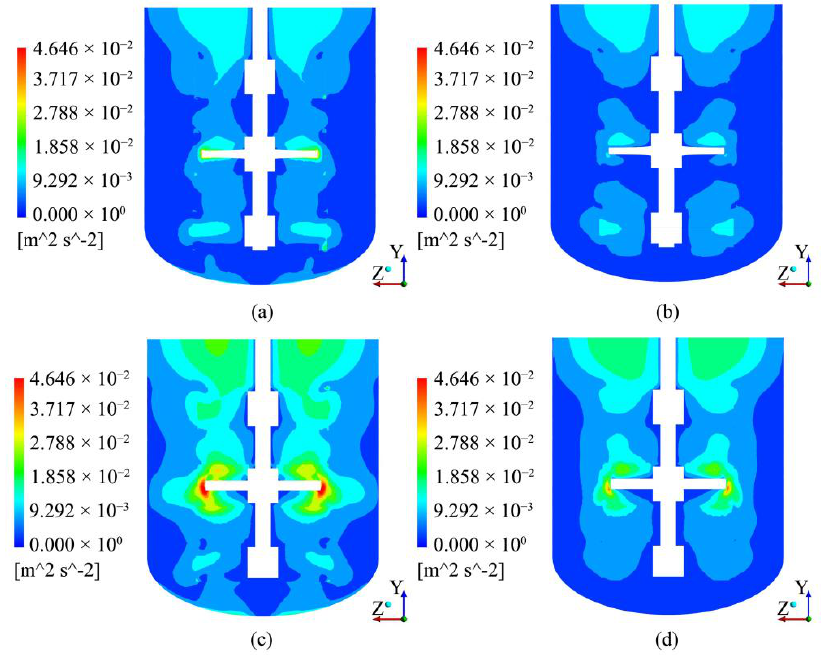
Figure 18. Cloud diagram of the turbulent kinetic energy in the YZ section. ( a ) Re = 2316.5, μ = 0.023 Pa·s,TBC-A type agitator; ( b ) Re = 44,910, μ = 0.001 Pa·s,TBC-A type agitator; ( c ) Re = 2316.5, μ = 0.023 Pa·s,TBC-B type agitator; ( d ) Re = 44,910, μ = 0.001 Pa·s,TBC-B type